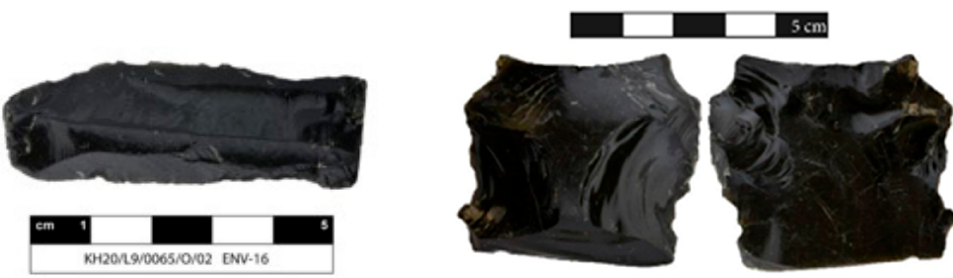
Figure 5. A retouched blade and splintered tools from Kendale Hecala.